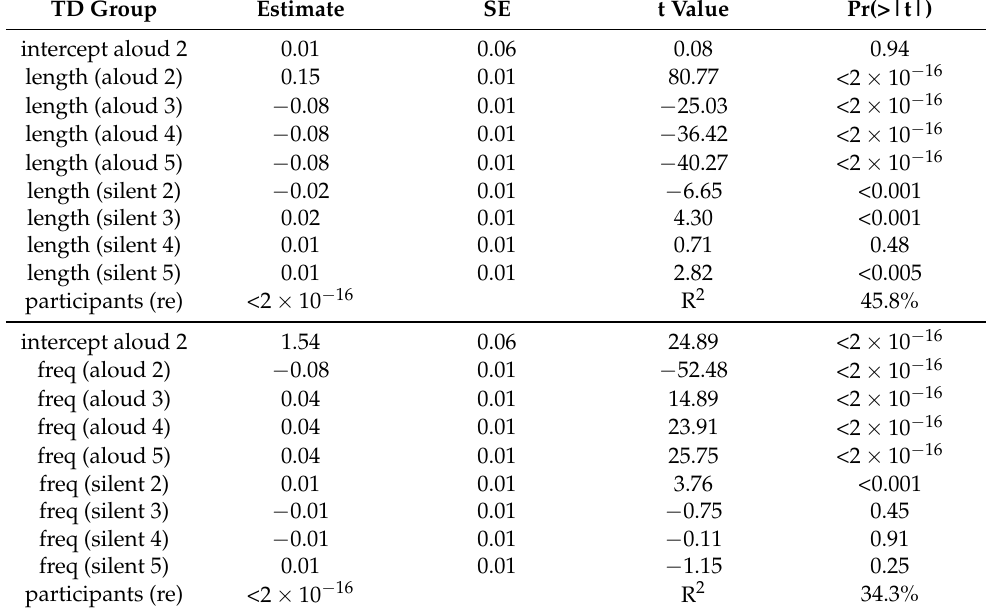
Table 5. GAM coefficients for models fitting tracking time as a function of word length ( length ) or (log)frequency ( freq ) in interaction with grade levels (2, 3, 4, 5) for the two reading modalities. Participants in the control group (TD) are added as random effects ( re ).